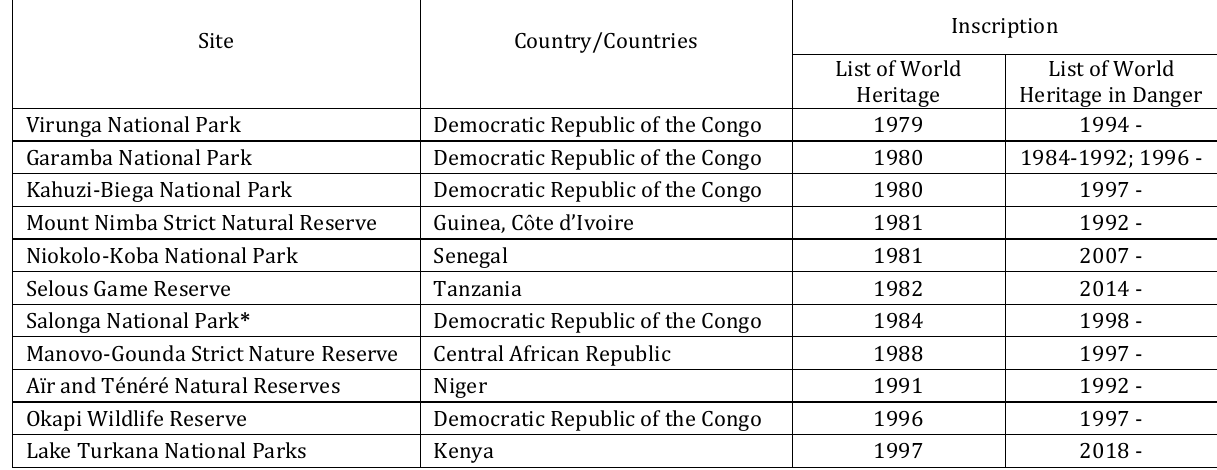
Table 6. African World Heritage in Danger in